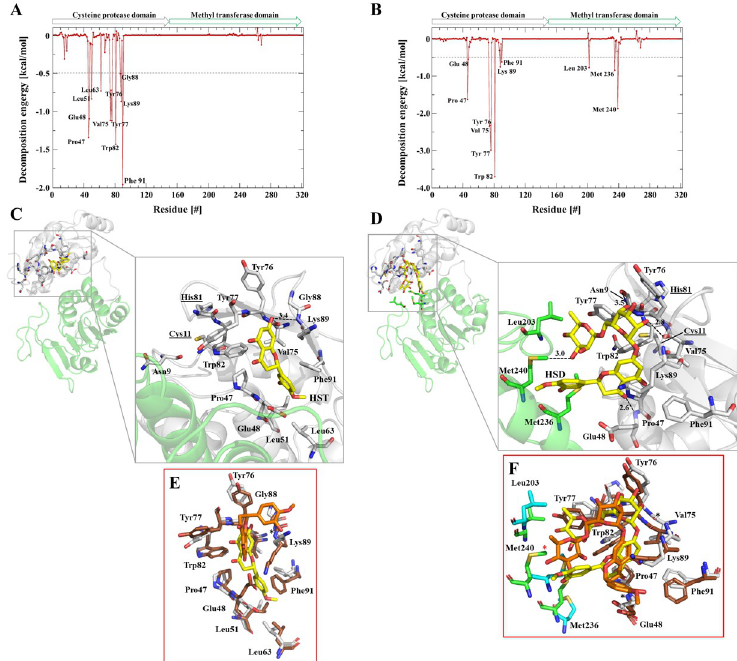
Fig 6. Amino acids participating in the CHIKV nsP2 pro -HST and -HSD interaction. A: Decomposition of the binding energy of CHIKV nsP2 pro -HST complex. Arrows label the protease domain (gray) and methyltransferase domain (green). The residues involved in the interaction between protease and HST are labeled. B: Decomposition of the binding energy of CHIKV nsP2 pro -HSD complex. The residues involved in the interaction between protease and HSD are labeled. C: 3D structure of CHIKV nsP2 pro (PDB entry: 3TRK), the protease domain is colored in gray and methyltransferase domain in green. Amino acids highlighted that are involved in the interaction with HST (yellow) based on MD simulations. The H-bond between Lys89 and HST is highlighted. D: 3D structure of CHIKV nsP2 pro , amino acids highlighted are involved in the interaction with HSD (yellow) based on MD simulations. The H-bonds between Tyr77, Met240, Val75 and Glu48 with HSD are highlighted. E: Structural overlay of the representative CHIKV nsP2 pro -HST complex structures of two independent MD runs (RMSD: 1.259 Å ). Run1: nsP2 pro (gray), HST (yellow) and run2: nsP2 (brown), HST (orange). The binding region of HST is highlighted, the involved amino acids and HST position differs between run1 and run2. In run2 Pro47, Leu51, Leu63 and Ph91 are not interacting by hydrophobic interactions with HST. However, Lys89 forms in run2 like in run1 a hydrogen bond to HST, the distances between donor and acceptor differs slightly between MD run1 and run2 (3.4 to 3.5 Å ). F: Structural overlay of the representative CHIKV nsP2 pro -HSD complex structures of two independent MD runs (RMSD: 1.733 Å ). Run1: nsP2 pro (gray), methyltransferase domain (green), HSD (yellow) and run2: nsP2 (brown), methyltransferase domain (cyan), HST (orange). The binding region of HST is highlighted, the involved amino acids and HST position differs slightly between run1 and run2. The main difference concerns Met240, which forms in run1 a hydrogen bond, in run2 this interaction is not more formed, the distance increased from 3.0 to 5.5 Å . Because of this observation, Met240 will be not further considered. The hydrogen bonds formed by Glu48, Val75 and Tyr77 remain unaffected.